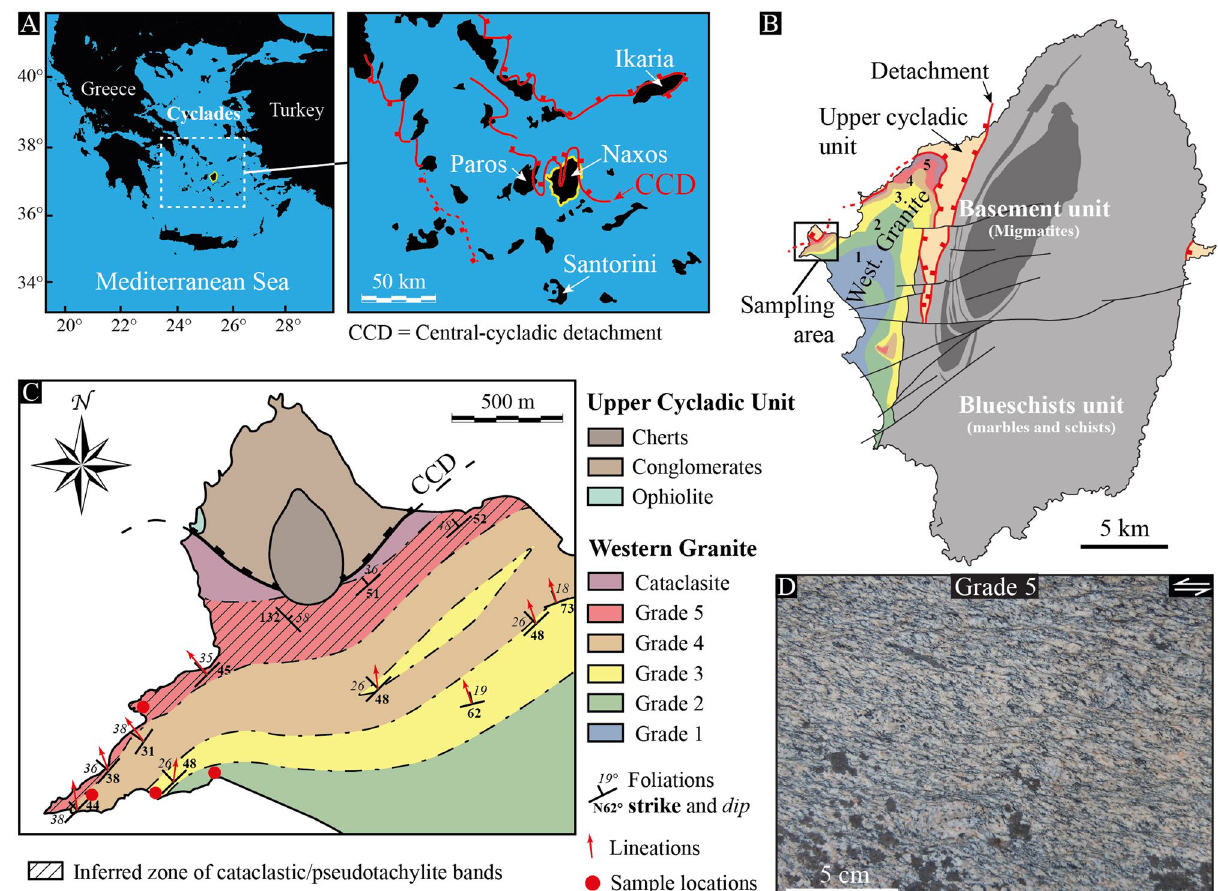
Figure 1. The Naxos strain gradient. ( A ) Location of the Naxos Island in the Cyclades and its position with respect to major detachments of the Aegean domain, including the central-Cycladic one (modified after Jolivet et al. 16 ). ( B ) Simplified structural map of Naxos locating the western granite of the island (modified after Bessière et al. 27 ). In color are shown the deformation grades from 1 to 5, as well as the sampling area of this study. ( C ) Structural map of the sampling area, including the sample location from grade 2 to grade 5 27 . ( D ) Outcrop picture of the Naxos granite illustrating quartz-rich shear bands in grade 5. The photograph is oriented normal to the shear plane and parallel to the shear direction (X–Z structural plane) with top-to-the-left